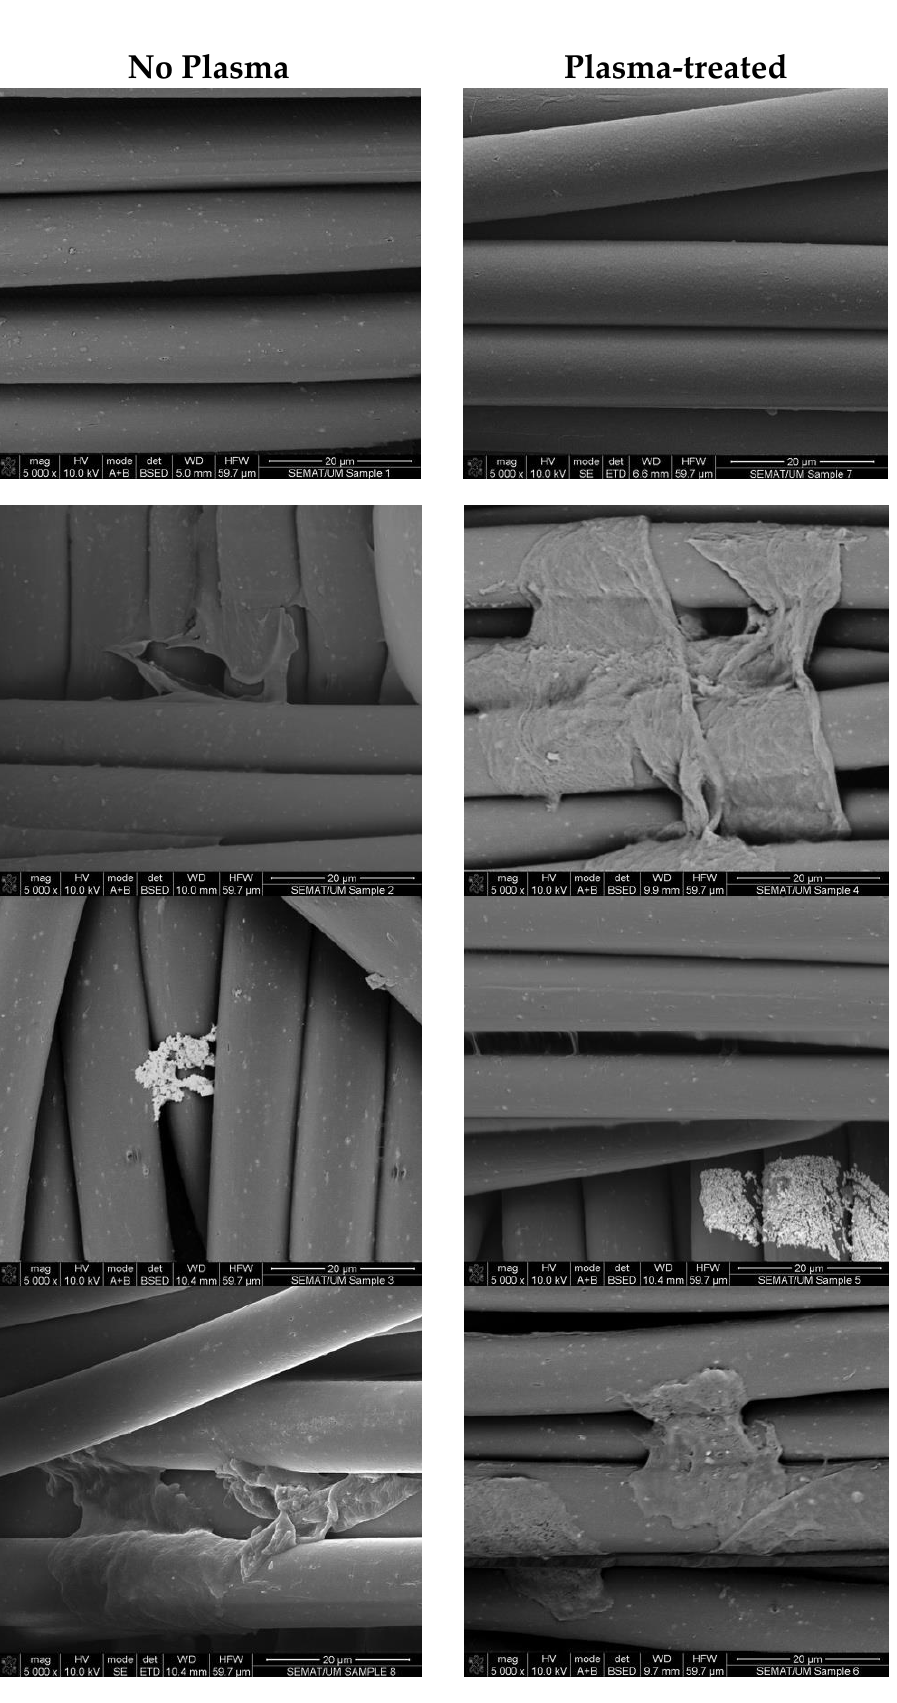
Figure 3. SEM images of the surface of nylon fabrics before (left column) and after (right column) plasma treatment. The lines depict the surface of the nylon textile prior to the functionalization (control), functionalized with chitosan (Nylon + chitosan), with Ag NPs (Nylon + Ag NPs) and with both antimicrobial agents (Nylon + Ag NPs + chitosan).